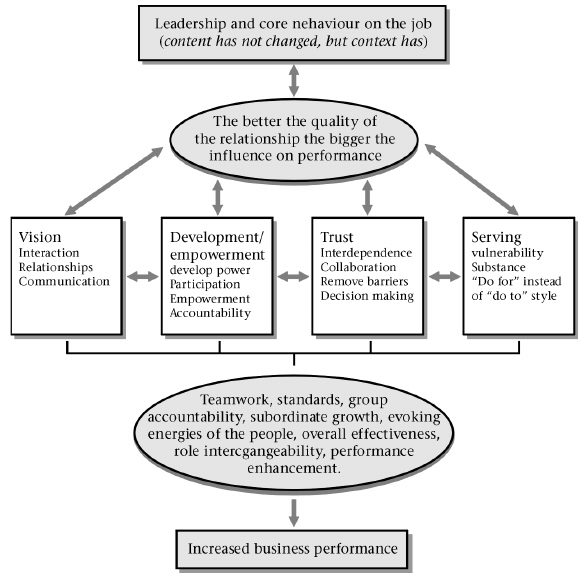
Figure 3: New leadership/employee relationship